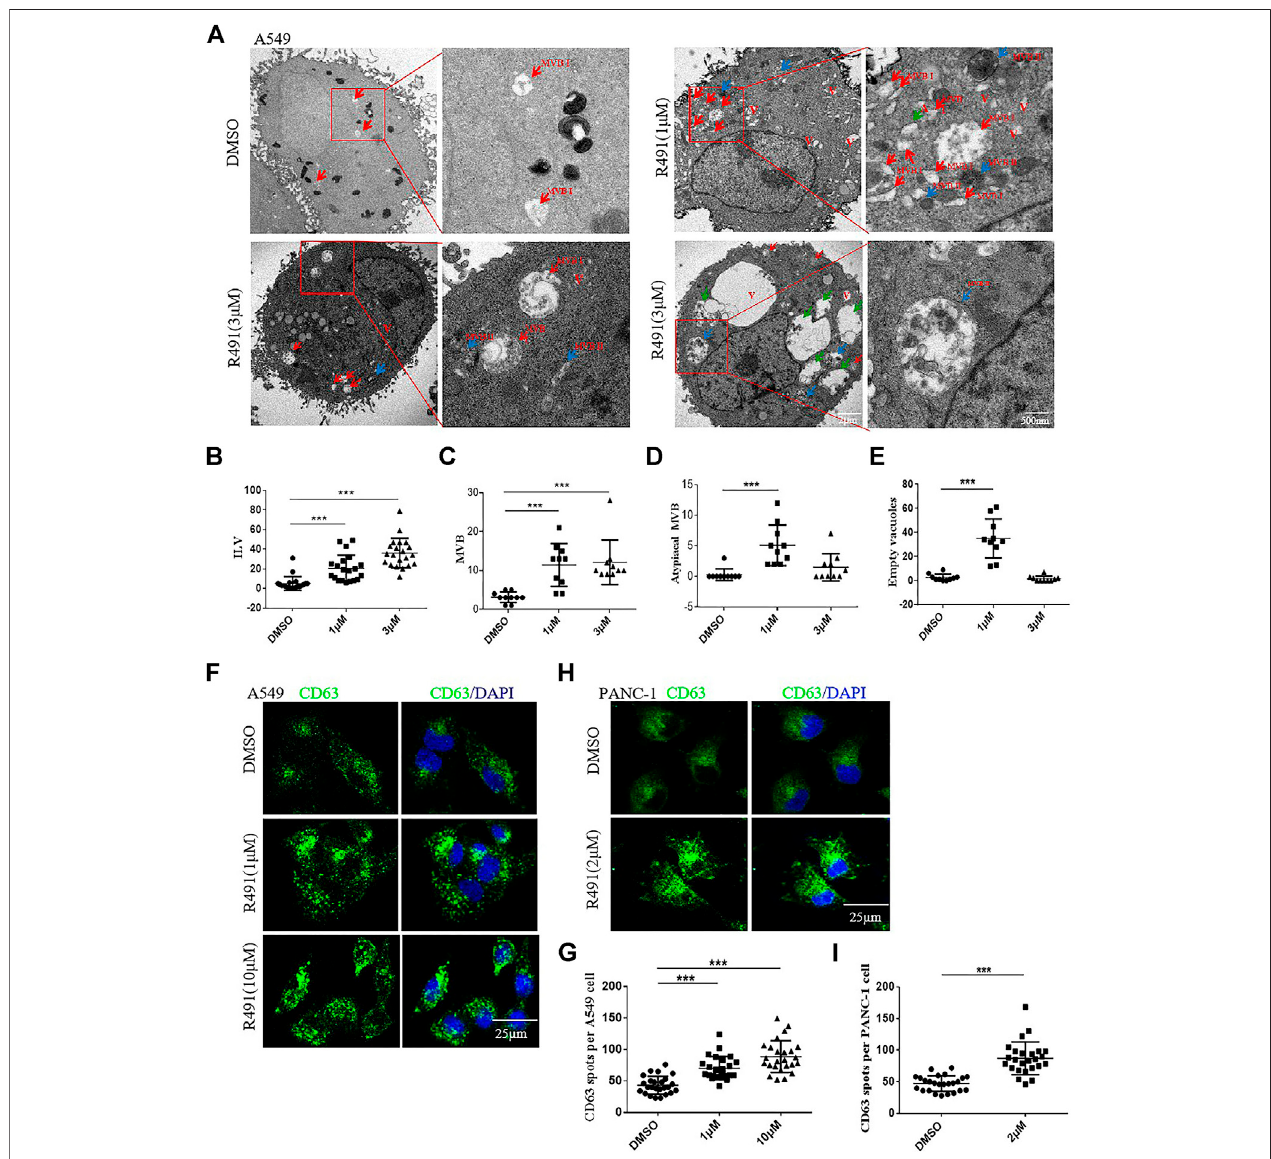
FIGURE 3 | Analysis of the intracellular vacuole accumulation induced by R491 revealed a disturbed exosomal pathway. (A) Representative transmission electron micrographs of A549 cells treated with DMSO or R491 (1 and 3 µM), showing morphologies of MVB I (red arrows), MVB II (blue arrows), atypical MVB II (green arrows) and empty vacuoles (V).Scalebars:2 μ m; 500 nm. (B – E) Quanti fi cationoforganelles present inthecellstreatedwithDMSO andR491(1and3 µM). NumberofILVs (B) ineachMVB(n (cid:2) 20);numbersofMVBs (C) ,atypicalMVBs (D) andempty vacuoles(V) (E) percell(n (cid:2) 10)wereexpressedasmean ± SEM.Statisticalsigni fi cance: *** p < 0.001asdeterminedbyMann-Whitneytest. (F,H) ConfocalmicroscopyanalysisoftheendosomemarkersCD63(green)intheA549 (F) andthePANC-1 (H) cells treated with DMSO and R491 (1 and 10 µM). Scale bar: 25 µm. (G, I) Quanti fi cation of the number of CD63 + particles per A549 (G) and PANC-1 (I) cell. The dot plot representsthenumberofCD63 + fromindividualcells(n (cid:2) 25).Thedataareexpressedasmean ± SEM(n (cid:2) 25).*** p < 0.001asdeterminedbytwo-tailedStudent ’ st-test.